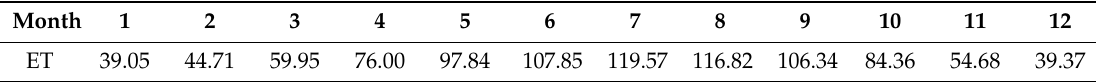
Figure 5. Spatial distribution of the ET in the PRB.